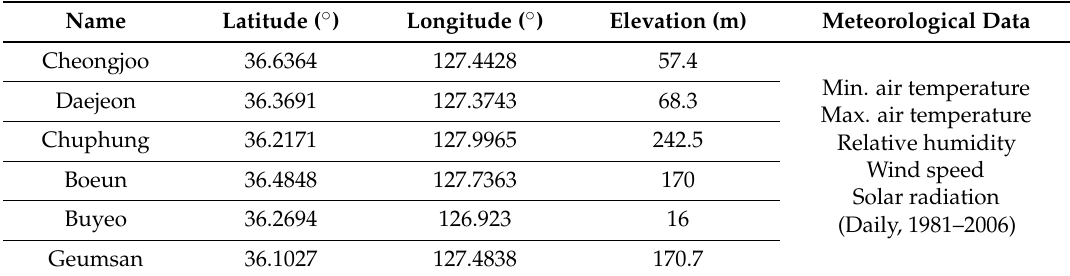
Table 2. Weather stations in the Geum River basin.